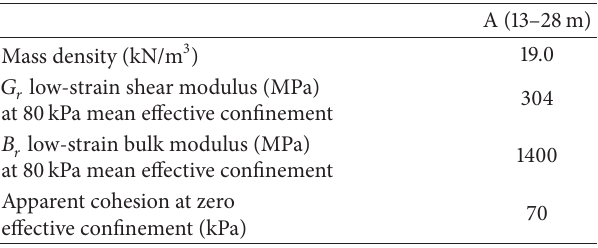
Table 3: Characteristics adopted in the study for A